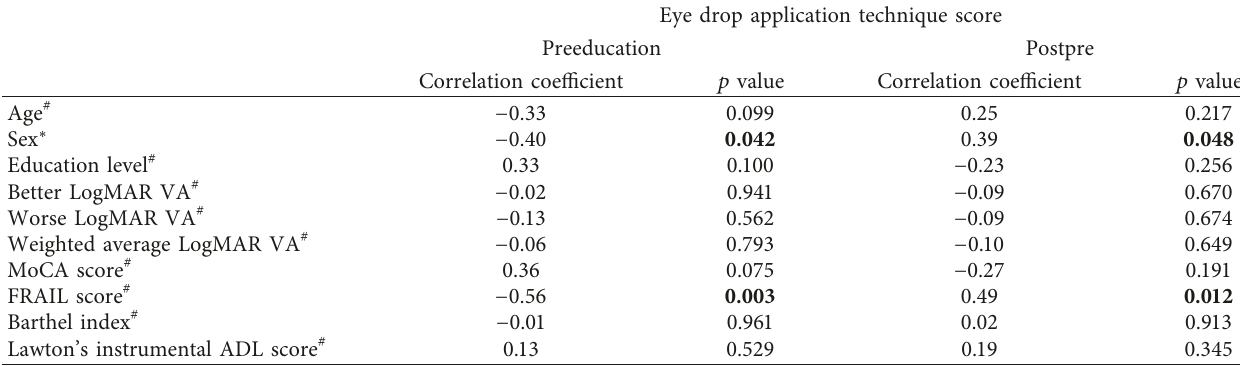
Table 2: Univariate analysis for predicting the correlation between eye drop technique scores and demographic and clinical cognitive variables.